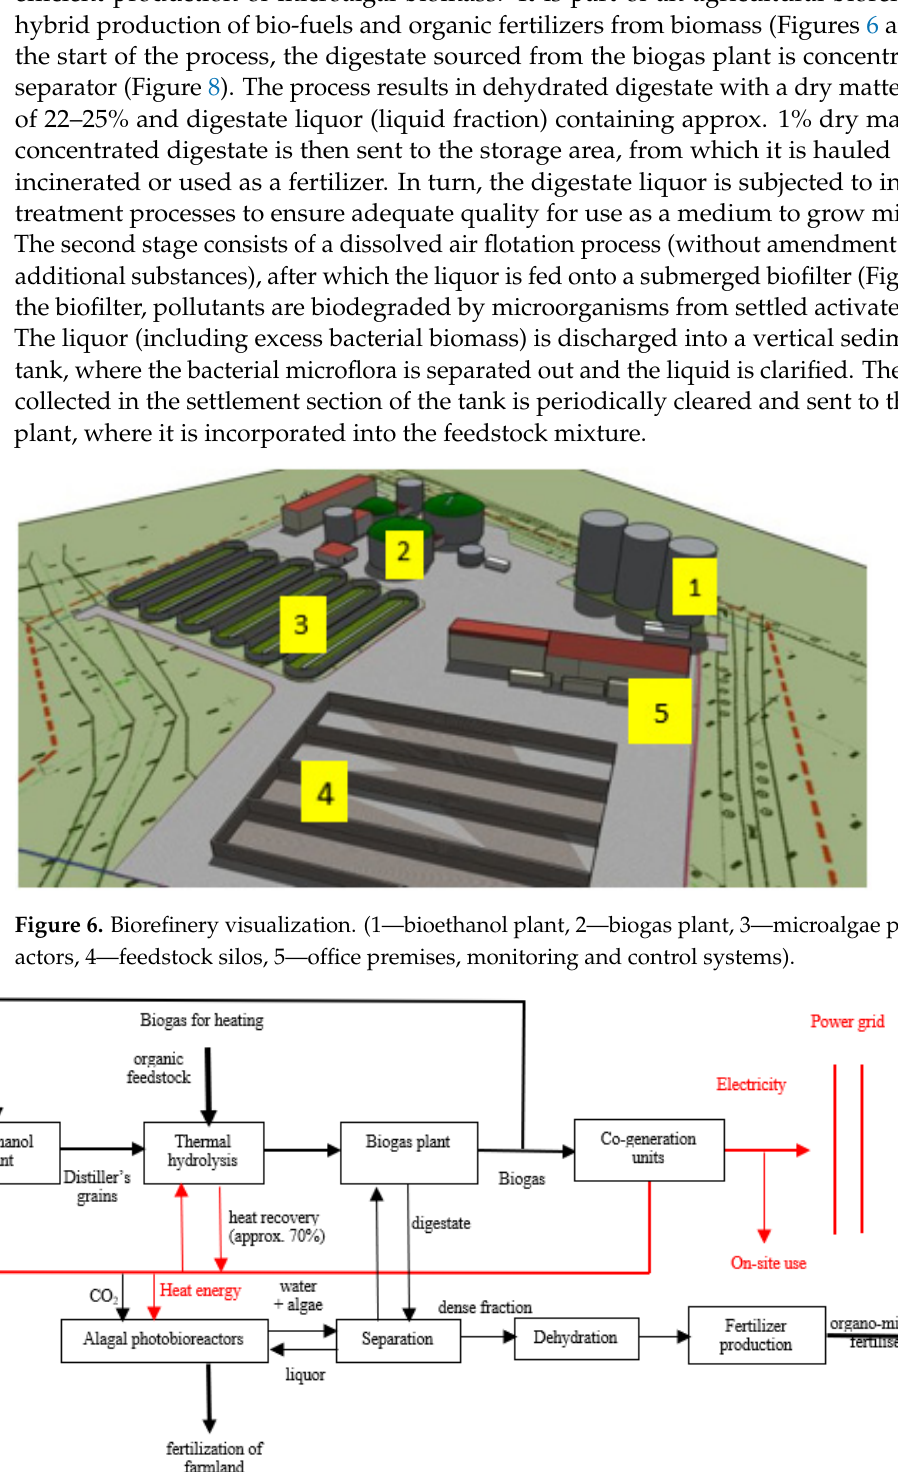
Figure 7. Flowchart of the biorefinery plant.